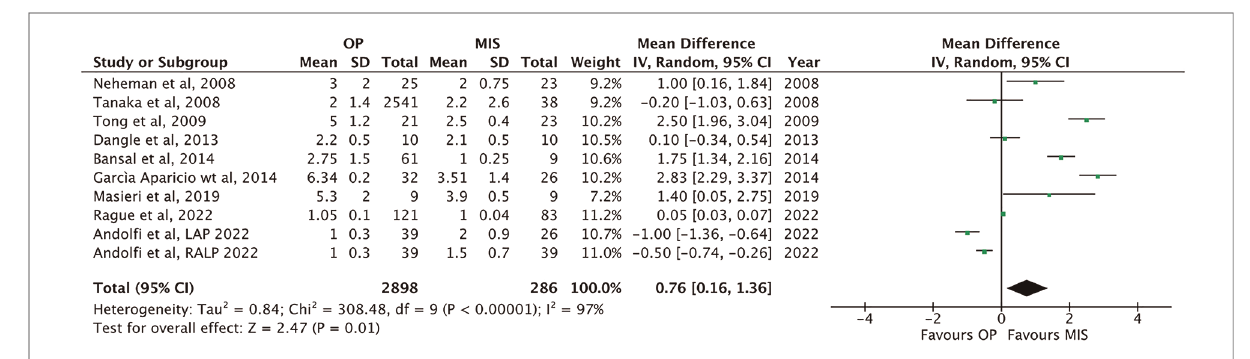
FIGURE 5 Forest plot comparison of the length of hospital stay between OP and MIS in infants.